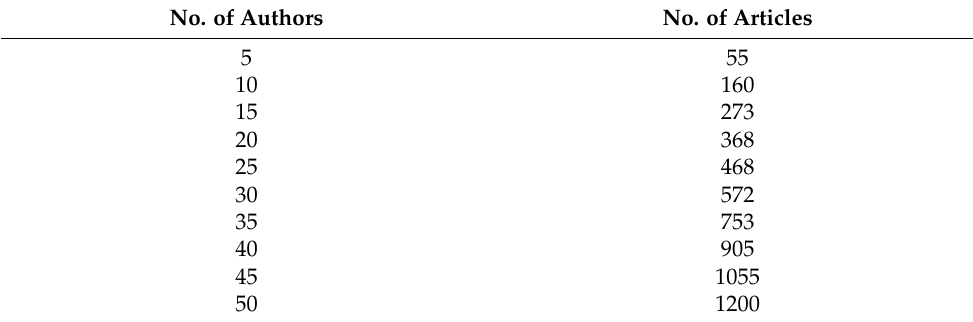
Figure 5. The sample text written by Sunil Gangopadhyay [3]. Table 2. The partitioned dataset illustrating the number of articles for each set.